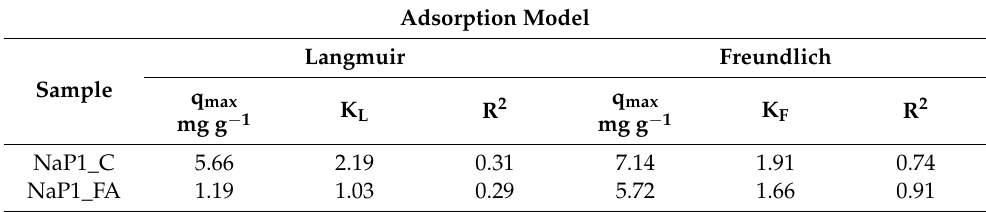
Table 4. Freundlich and Langmuir parameters for the adsorption isotherms.